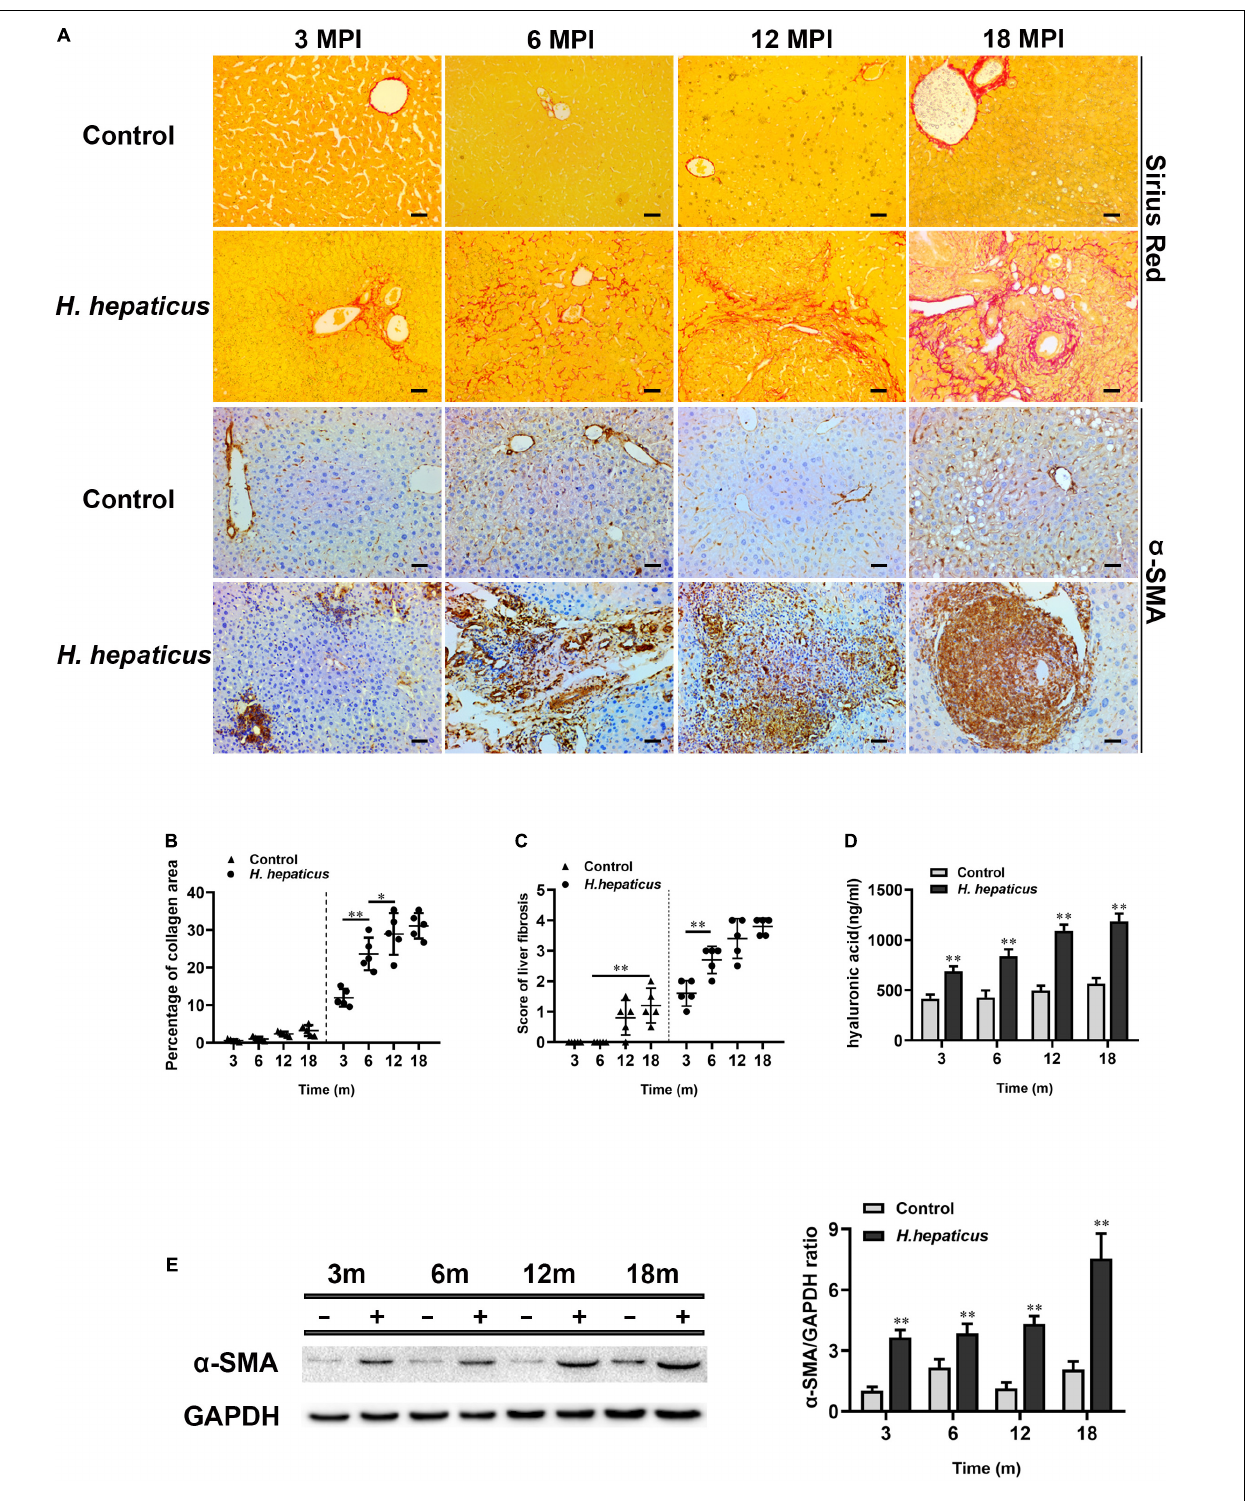
FIGURE 4 | Helicobacter hepaticus infection induced liver fibrosis. (A) Sirius red staining and immumohistochemical staining (IHC) of α -SMA images of liver sections at all time points (magnification, × 200). (B) Quantitative morphometry of collagen positive area. (C) The scores of the degree of liver fibrosis. (D) The levels of serum hyaluronic acid activity between the H. hepaticus –infected groups and control groups. (E) The expression level of α -SMA was detected and analyzed by Western blot. Data are expressed as the means ± SD ( n = 5). * p < 0.05 as compared to the control. ∗∗ p < 0.01 as compared to the control. Each group contained five mice.